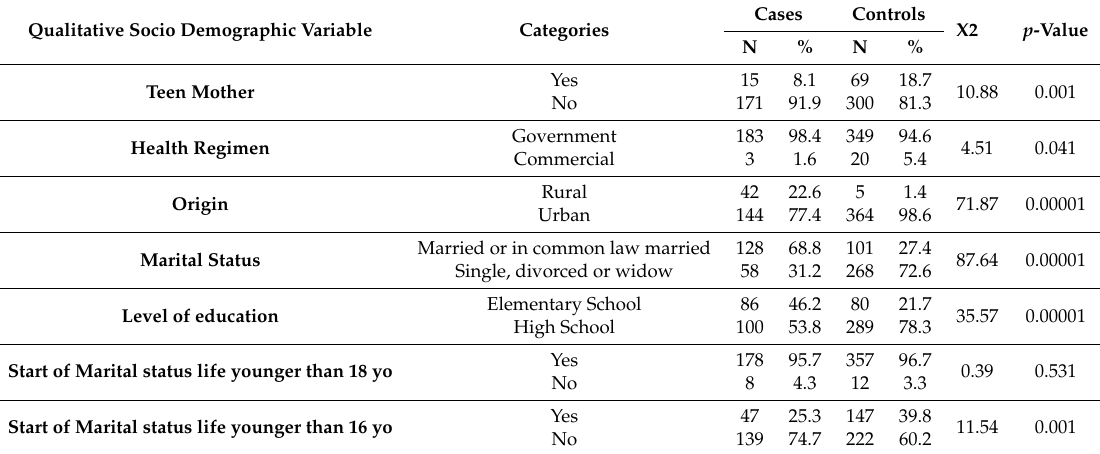
Table 5. Qualitative sociodemographic variables in cases (186) and controls (369).